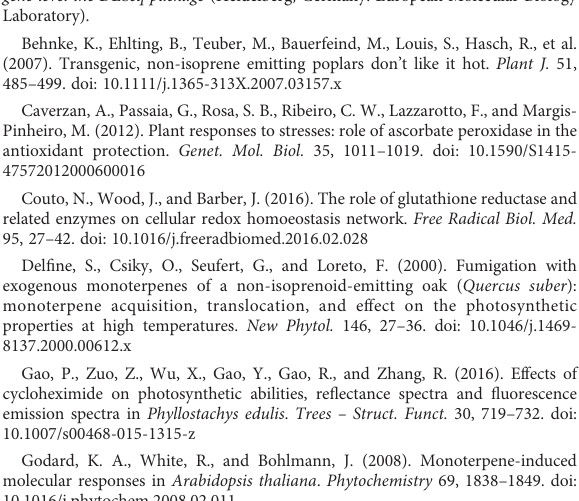
SUPPLEMENTARY FIGURE 1 Effects of eucalyptol on the maximum quantum yield of primary photochemistry ( j Po) and non-photochemical deexcitation ( j D O ) in eucalyptol chemotype of C. camphora under normal temperature. Compared with 28°C, the fumigation with 1, 3 and 5 µM eucalyptol (Eul) at 28°C not changed the j Po and j D O , indicating that monoterpene fumigation no affect the photosynthetic abilities in C. camphora under normal